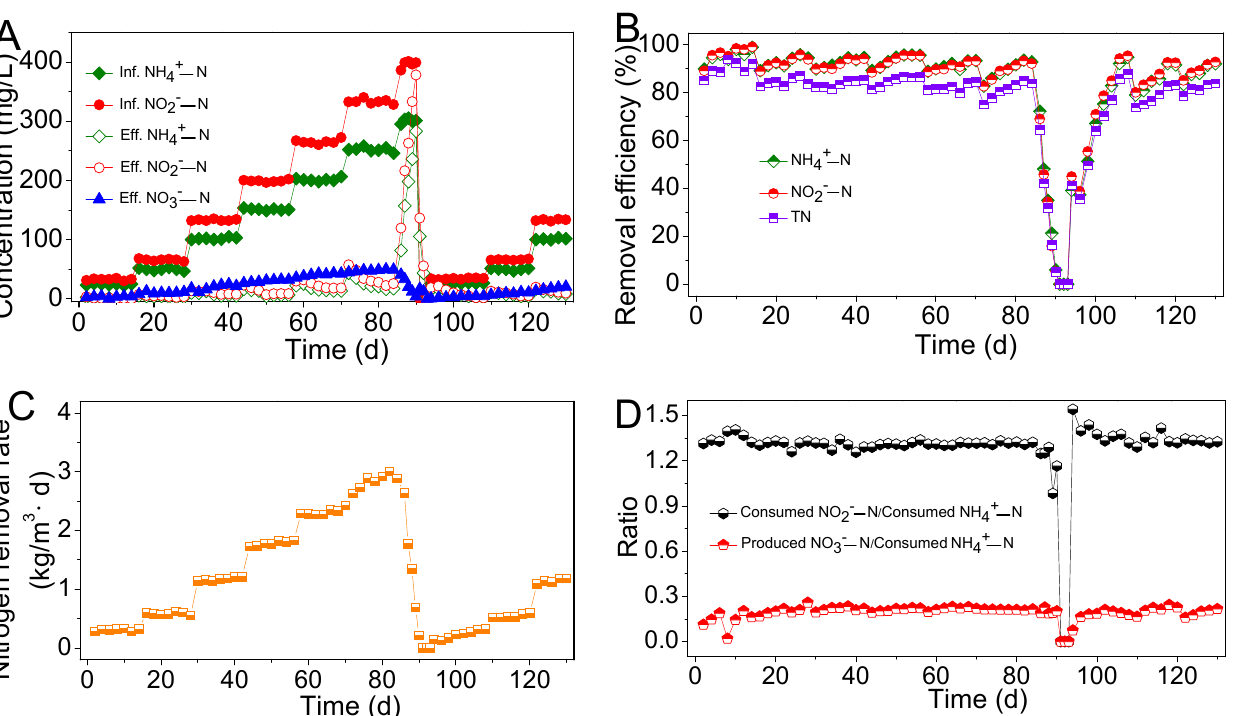
Figure 2. Nitrogen removal in the anode anammox MFC: ( A ) the concentrations of NH 4+ ‐ N, NO 2 − ‐ Nand NO 3 − ‐ N in the influent and effluent; ( B ) removal efficiency changes in NH 4+ ‐ N, NO 2 − ‐ N and TN; ( C ) variation in volumetric nitrogen removal rate over time and ( D ) ratio of consumed NO 2 − ‐ N to consumed NH 4+ ‐ N and ratio of produced NO 3 − ‐ N to consumed NH 4+ ‐ N.